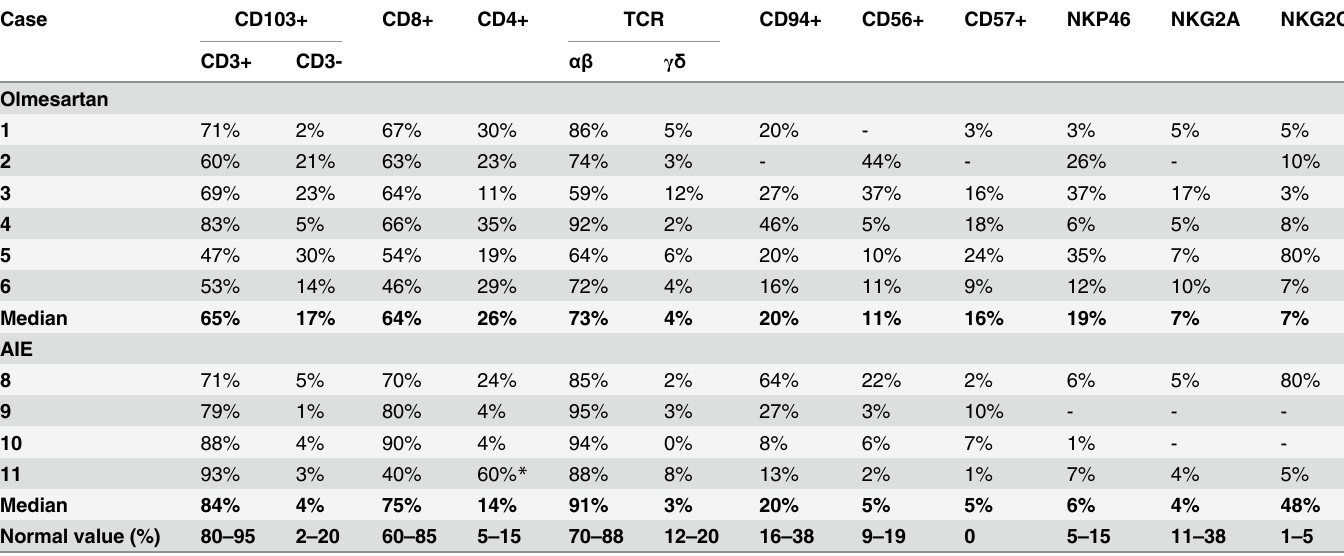
Table 2. Phenotype of intestinal intraepithelial lymphocytes.